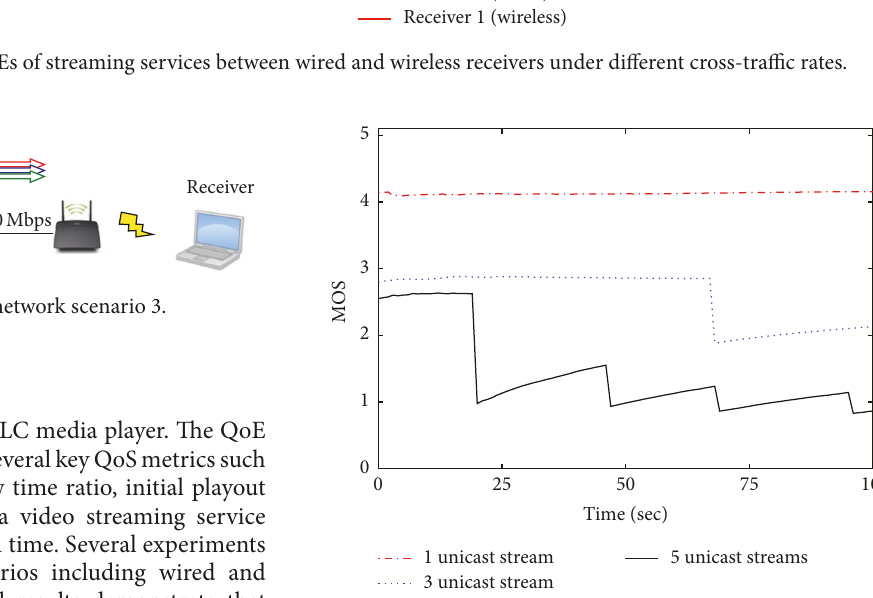
Figure 15: Impact of number of unicast streams on MOS of wireless